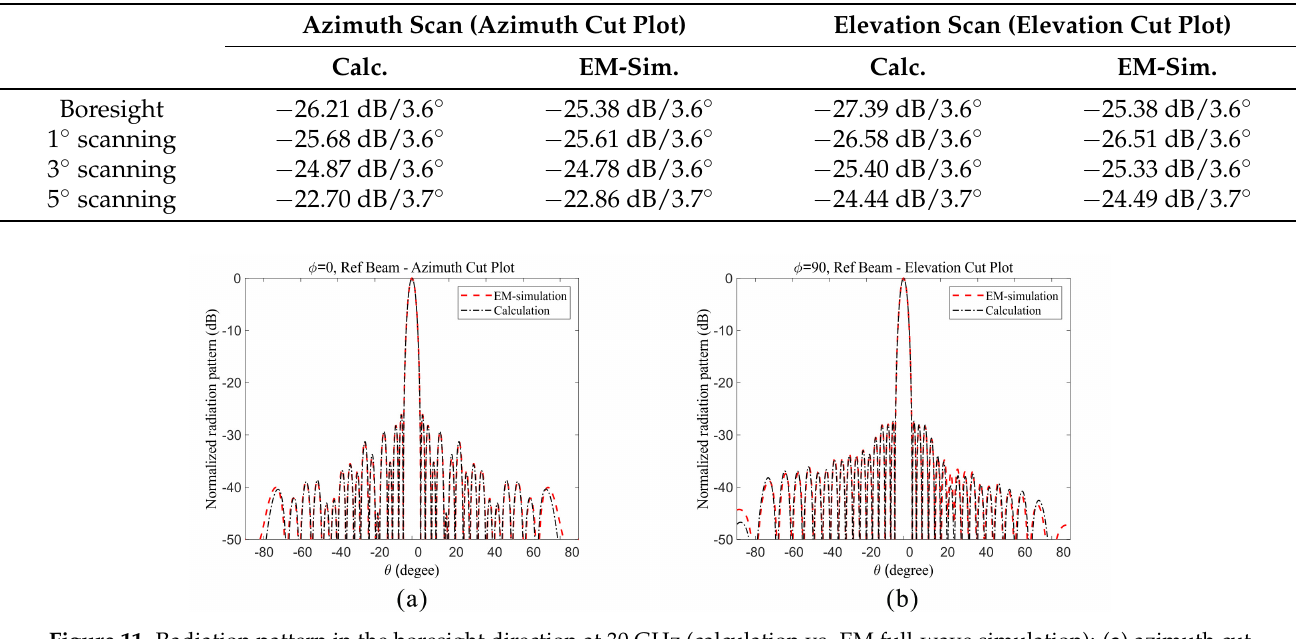
Table 3. Comparative analysis of the SLL/HPBW changes according to the beam-steering angle at 30 GHz (calculation vs. EM full-wave simulation).